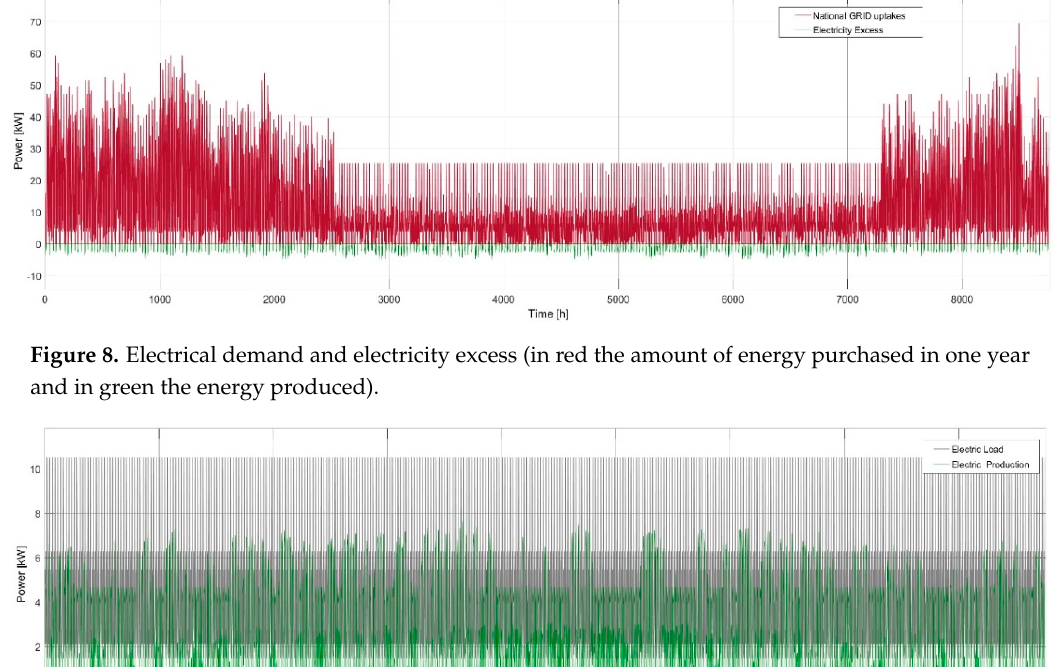
Figure 9. Electric load vs PV electricity production.